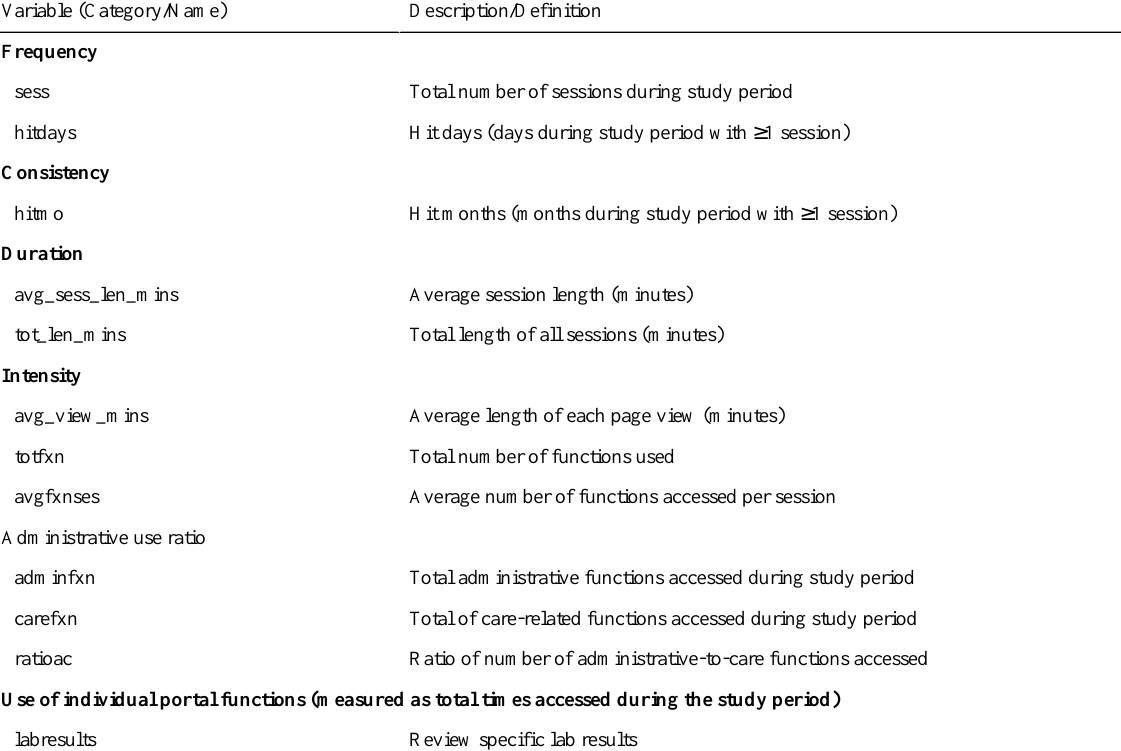
Table 1. Variables extracted from the log file. Description/DefinitionVariable